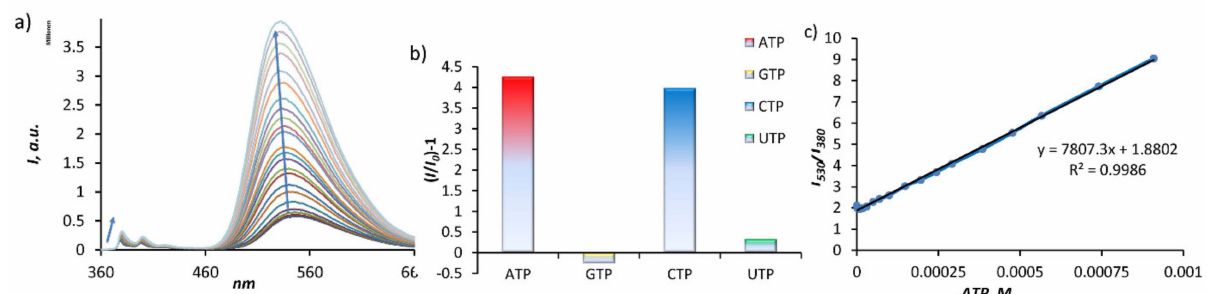
Figure 3. ( a ) Fluorescence changes observed during the titration of 7 (0.01 mM) with ATP (1 mM) in a 10-mM TRIS buffer (2% vol. DMSO, 100 mM NaCl, pH 7.4, ex.: 350 nm). ( b ) Fluorescence response of 7 towards nucleoside triphosphates. ( c ) Changes in intensity ratio I 530nm / I 380nm with increasing amounts of ATP